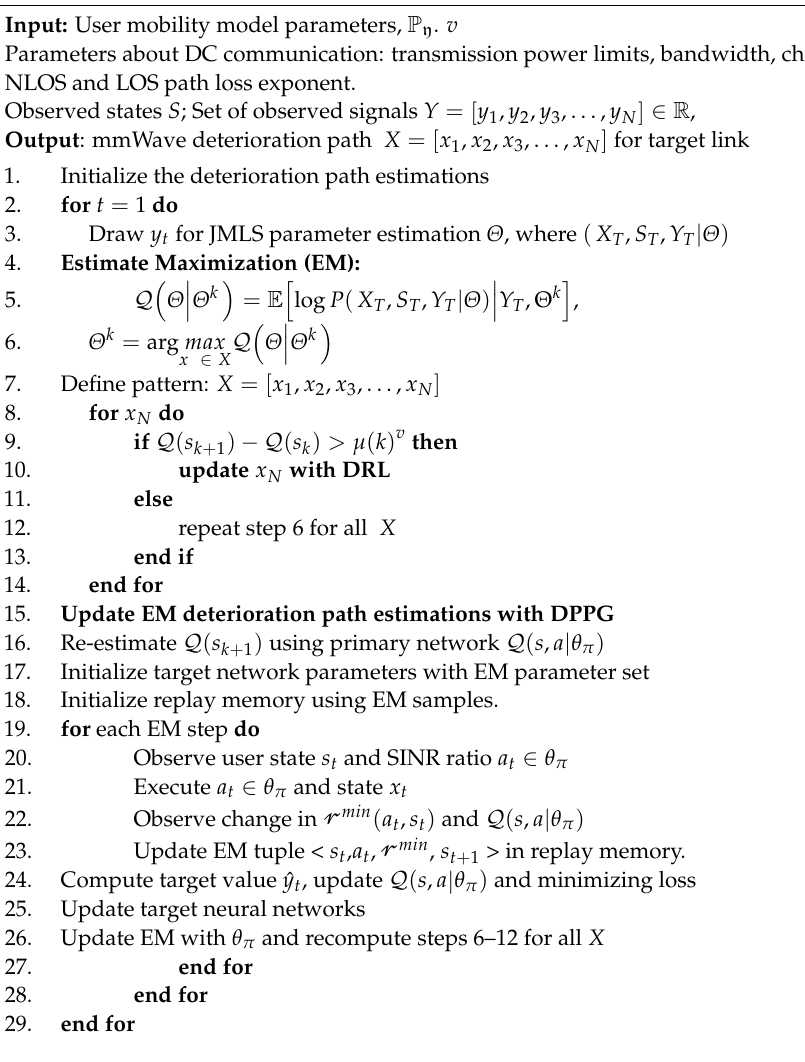
Algorithm 1: JMLS–DRL-Based Pattern